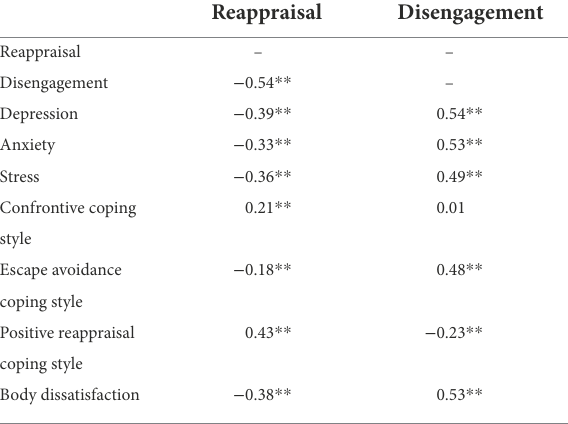
Table 4 Pearson correlation coefficients between bcri subscales scores and other study variables ( n = 256).